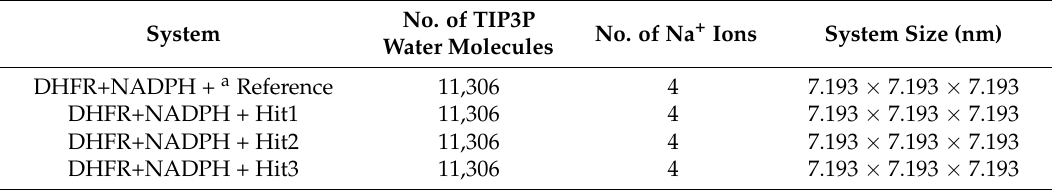
Table 5. The specifications of four systems used for molecular dynamics